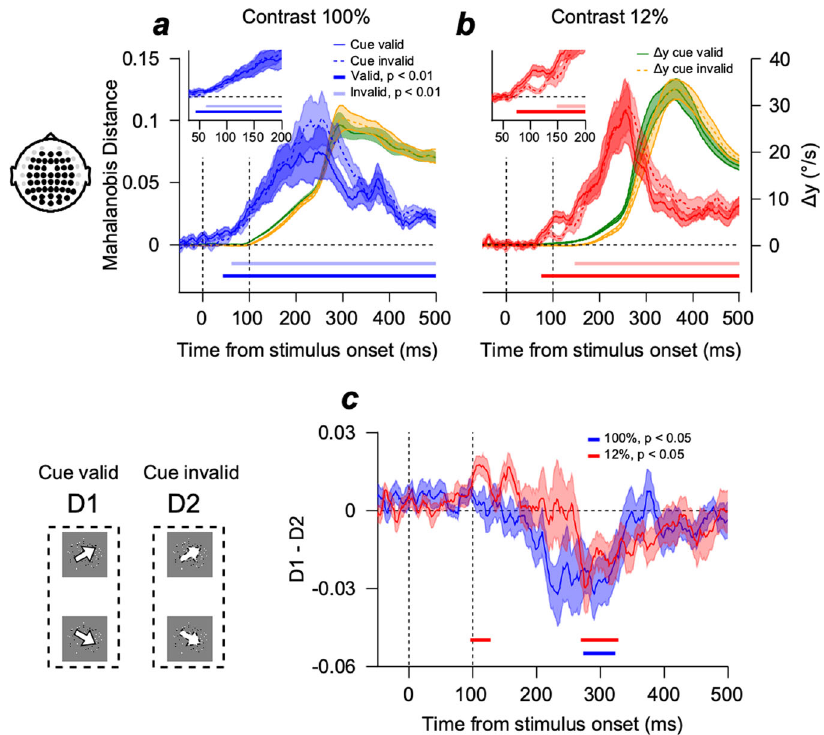
Fig. 2 Multivariate EEG activity pattern dissimilarity between upper and lower tracking trials estimated using Mahalanobis distance. a Pattern dissimilarity (Mahalanobis distance) of EEG activity aligned by the stimulus onset when the stimulus contrast was 100%. The solid blue and dashed lines are the EEG dissimilarity when the cue was valid and invalid, respectively. A visual stimulus appeared at 0 ms, and global motion occurred at 100 ms. The solid green line (cue-valid condition) and dashed yellow line (cue-invalid condition) show the eye velocity trace distance differences ( 4 y ) from Fig. 1e. The color-shaded areas denote standard errors. A fi gure at the left illustrates the electrodes used for the analysis. Insets show enlarged EEG dissimilarities. The dark-colored line (valid) and light-colored line (invalid) at the bottom of each plot show the time points where Mahalanobis distance was signi fi cantly different from zero (two-sided cluster-based permutation test, n = 14, cluster-de fi ning threshold p < 0 : 01, corrected signi fi cance level p < 0 : 01, 50,000 permutations). b Pattern dissimilarity of EEG activity when the stimulus contrast was 12%. The fi gure format is the same as in Fig. 2a. c Difference between EEG pattern dissimilarities of valid and invalid conditions. Neural direction discrimination in the cue-valid condition was signi fi cantly better than the discrimination in the cue-invalid condition only when stimulus contrast was 12% (96 – 128 ms). Later, neural direction discrimination was better in the cue- invalid condition than in the cue-valid condition across both stimulus conditions (two-sided cluster-based permutation test, n = 14, cluster-de fi ning threshold p < 0 : 05, corrected signi fi cance level p < 0 : 05, 50000 permutations). The color-shaded areas denote standard errors. The illustration at the left shows the pursuit target direction conditions used for calculating D1 and D2 in Fig. distance difference (Fig. 1f, red for 12% contrast, blue for 100% contrast). The average distance difference near the end of the open-loop period (at 100 ms after pursuit latency 16 ) was the largest (Fig. 1f, left top inset fi gure, two-sample t -test, n = 14, p ¼ 2 : 25 ´ 10 (cid:3) 5 ). The results suggest that manipulating the